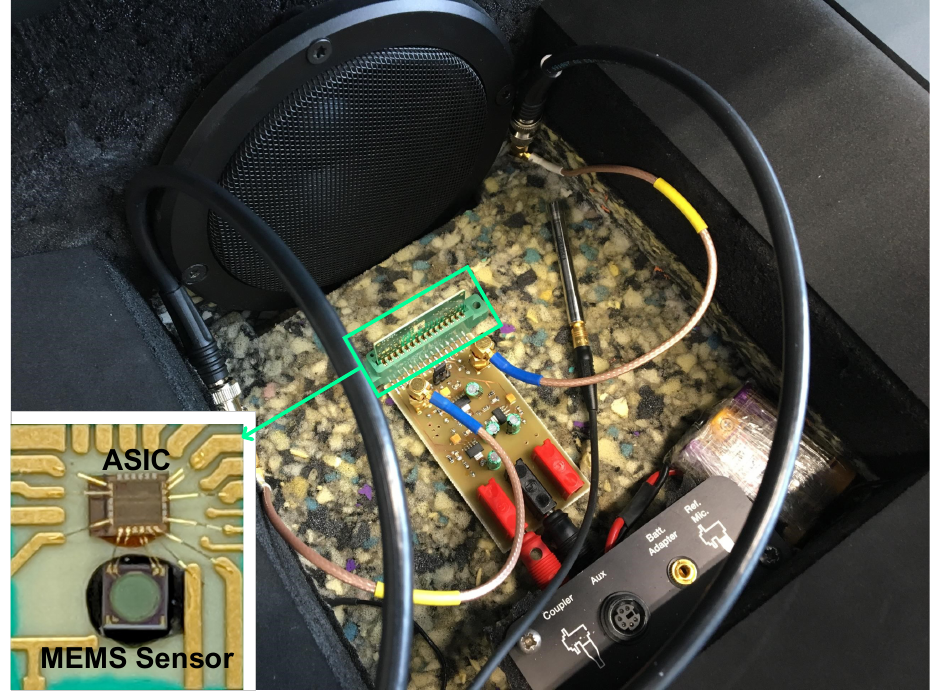
Figure 16. Test fixture used in the acoustical